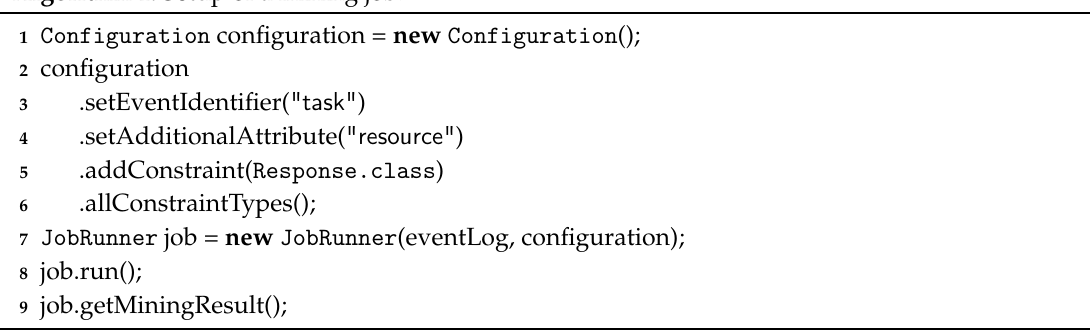
Algorithm 1: Setup of a mining job.